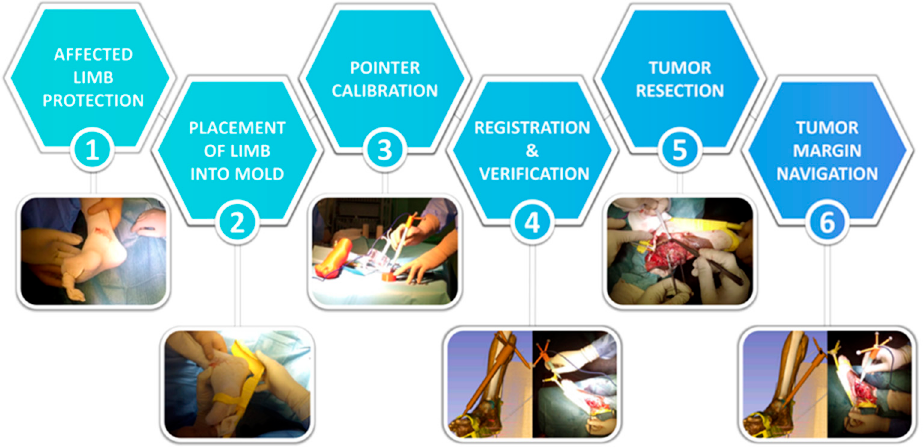
Figure 5. Proposed workflow for acral tumor resection surgeries.